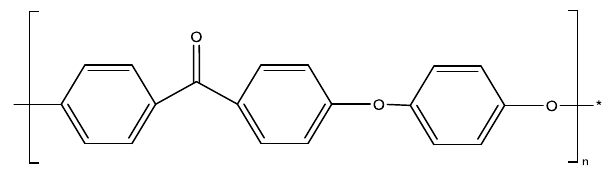
Figure 1. Chemical structure of Polyetheretherketone (PEEK).